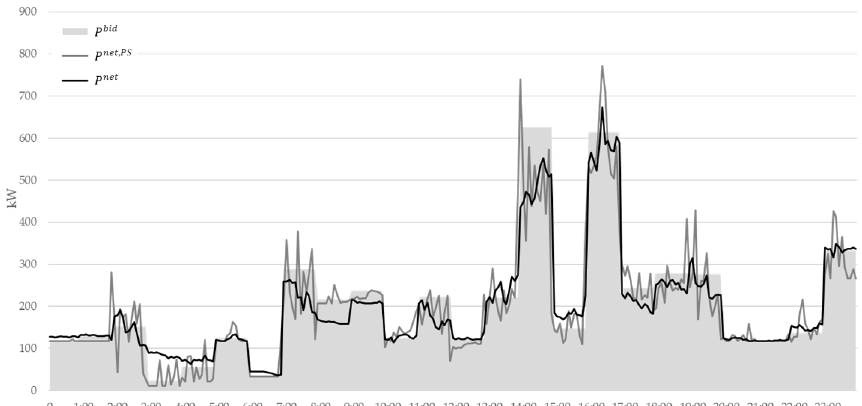
Figure 10. PS schedule and result of ID operation scheduling method of ( a ) an independent ESS and